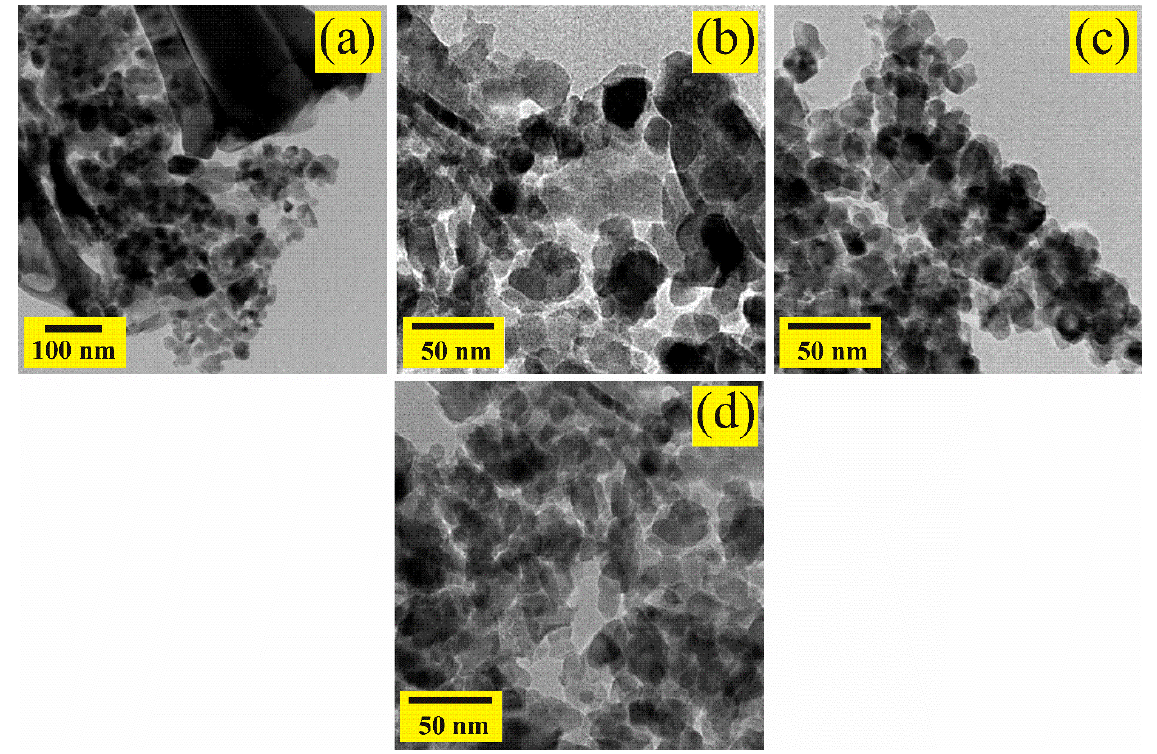
Figure 7 . TEM images showing the individual characteristics of the ZnAl 2 O 4 nanoparticles calcined at 300 °C: ( a ) growth of rods and nanoparticles, ( b ) agglomeration of nanoparticles to form the rods, ( c ) agglomeration of individual nanoparticles, ( d ) nucleation of different nanoparticle morphologies.